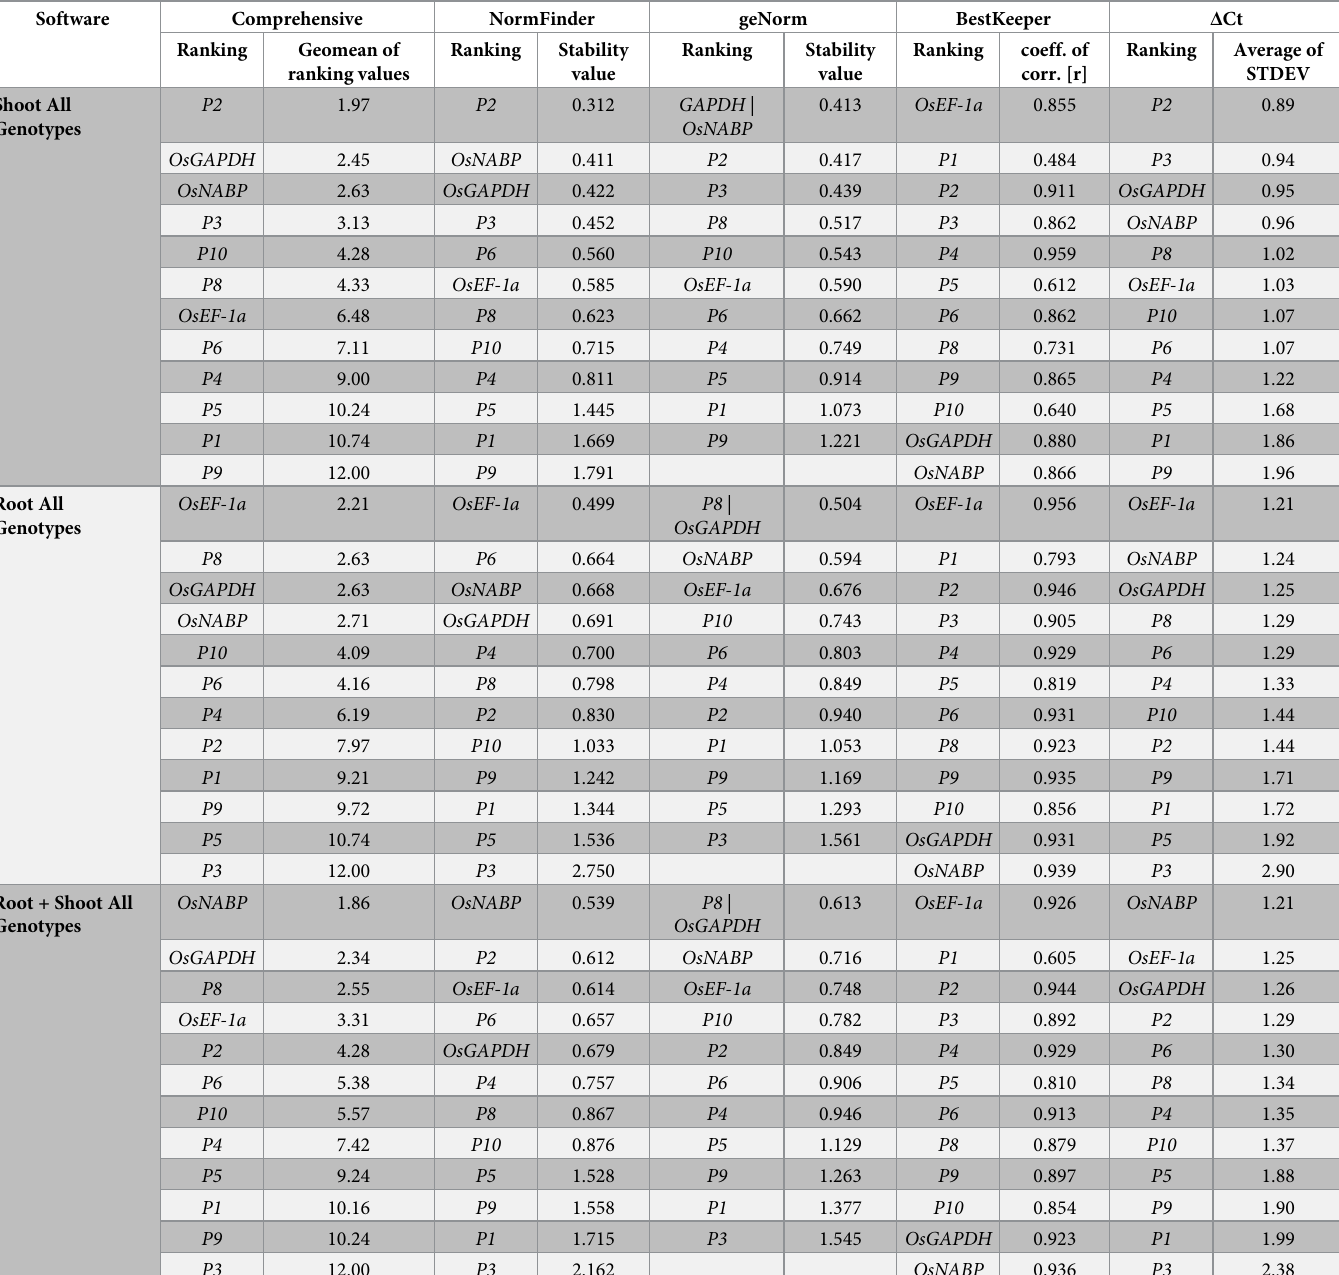
Table 3. Ranking of the 12 candidate reference genes according to their transcription stability. Software